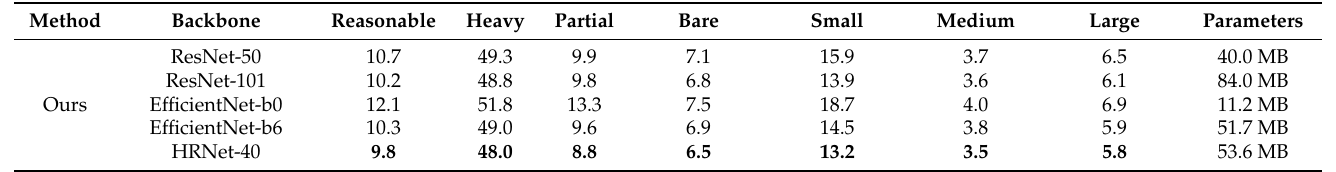
Table 4. The detection performance comparison between different feature extraction modules. The best results are highlighted in bold.